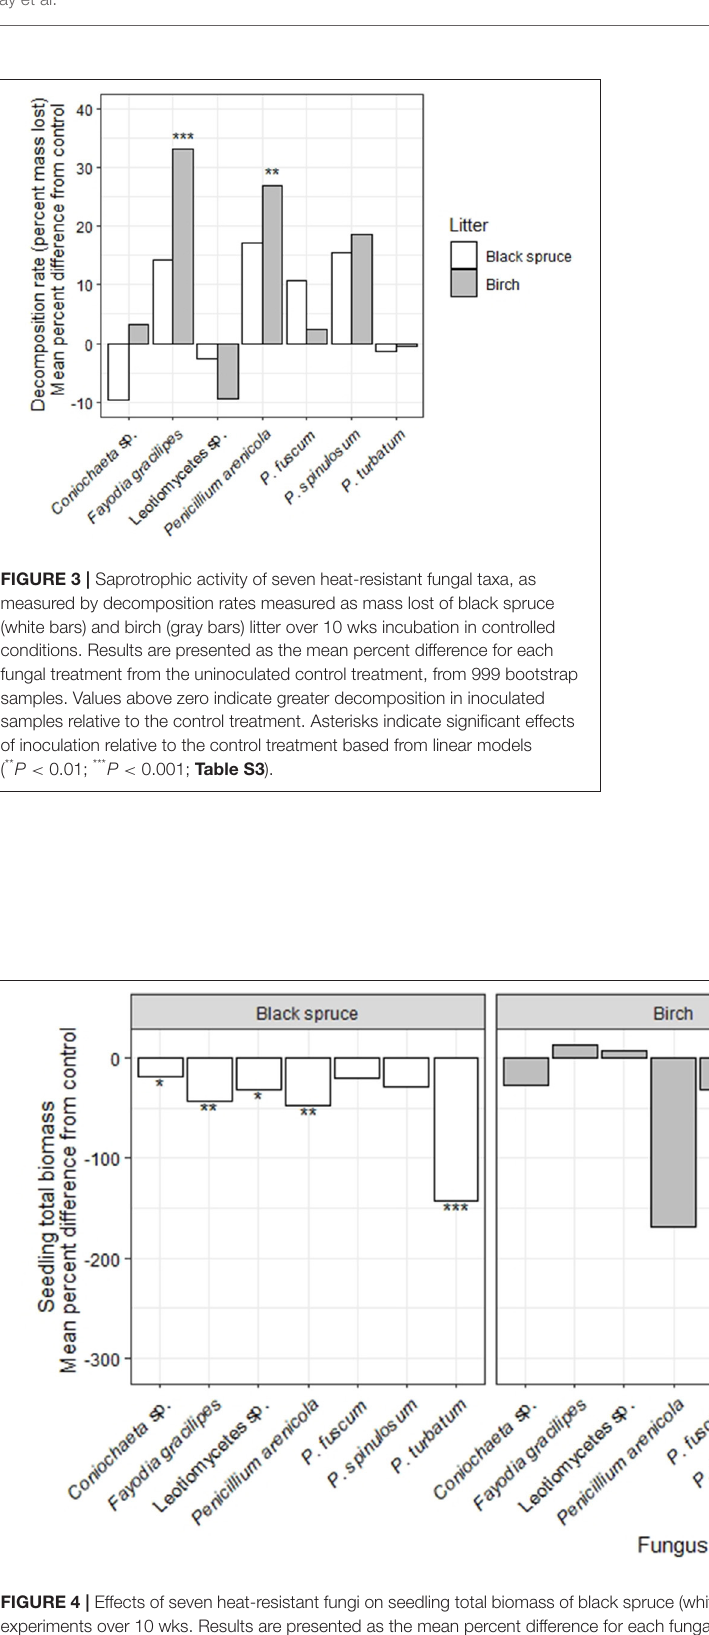
Frontiers in Forests and Global Change |